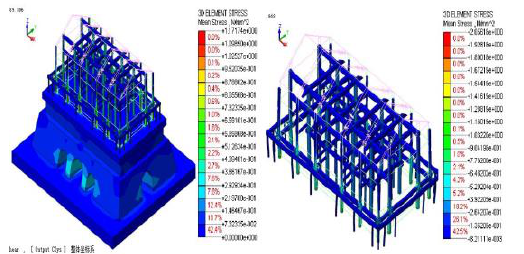
Figure 16. 1.2 Permanent load +1.4 Variable load overall maximum shear